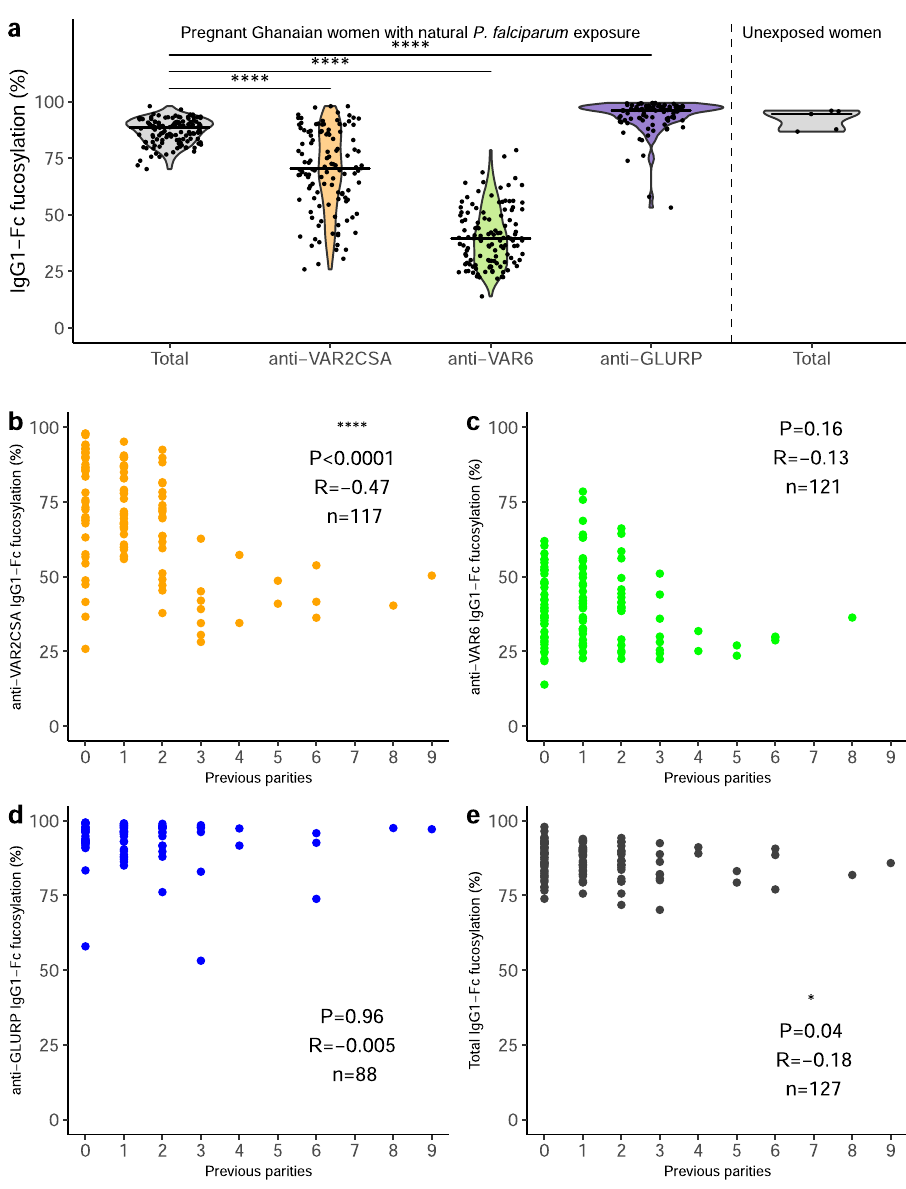
Fig. 2 Fc fucosylation of naturally acquired P. falciparum -speci fi c IgG depends on antigen location and exposure. a Fc fucosylation levels of total plasma IgG1 (gray, n = 127) and IgG1 speci fi c for VAR2CSA (orange, n = 117), VAR6 (green, n = 121), and GLURP (blue, n = 88) in Ghanaian pregnant women (left four panels). Fc fucosylation levels of total plasma IgG1 from unexposed Dutch women ( n = 5) were included for comparison (right panel). Medians and densities are shown. Statistically signi fi cant pairwise differences between antigen-speci fi c IgG and total IgG (multiple two-sided Wilcoxon signed-rank tests with Bonferroni correction) are indicated (**** P < 0.0001). b – e Correlations of b VAR2CSA-, c VAR6-, d GLURP-speci fi c, and e total IgG1-Fc fucosylation levels with parity. P values and correlation coef fi cients are shown. Statistical signi fi cance of correlations (Spearman ’ s correlations. * P <